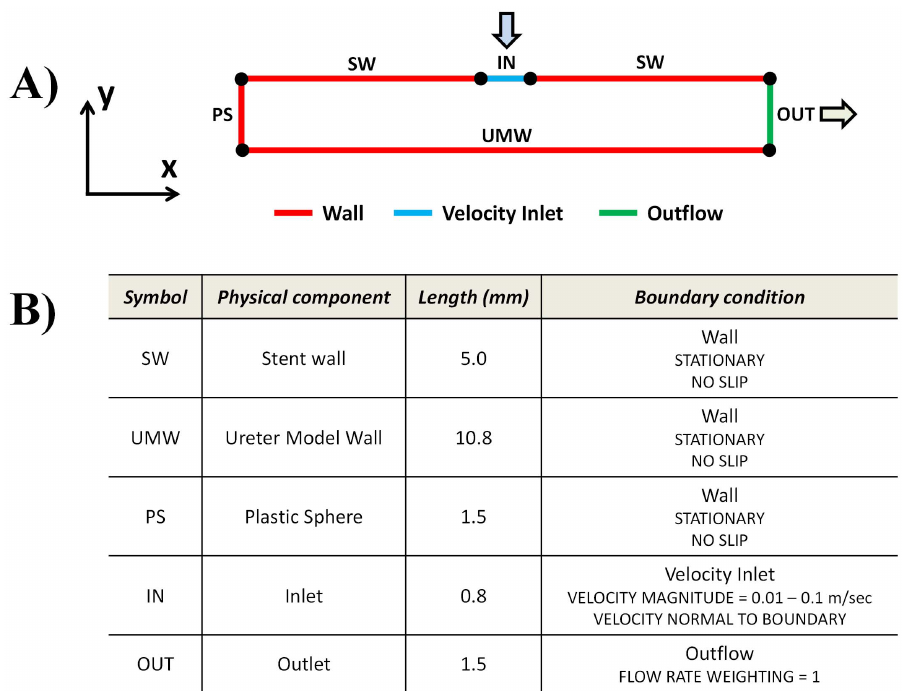
Figure 3. Schematic of the computational domain and boundary conditions. A) Schematic representation of the two-dimensional computational domain. Colours correspond to different boundary conditions: red wall boundary; green outflow; light blue velocity inlet. B) Summary of the geometrical characteristics of the computational domain, and boundary conditions applied to each individual edge.